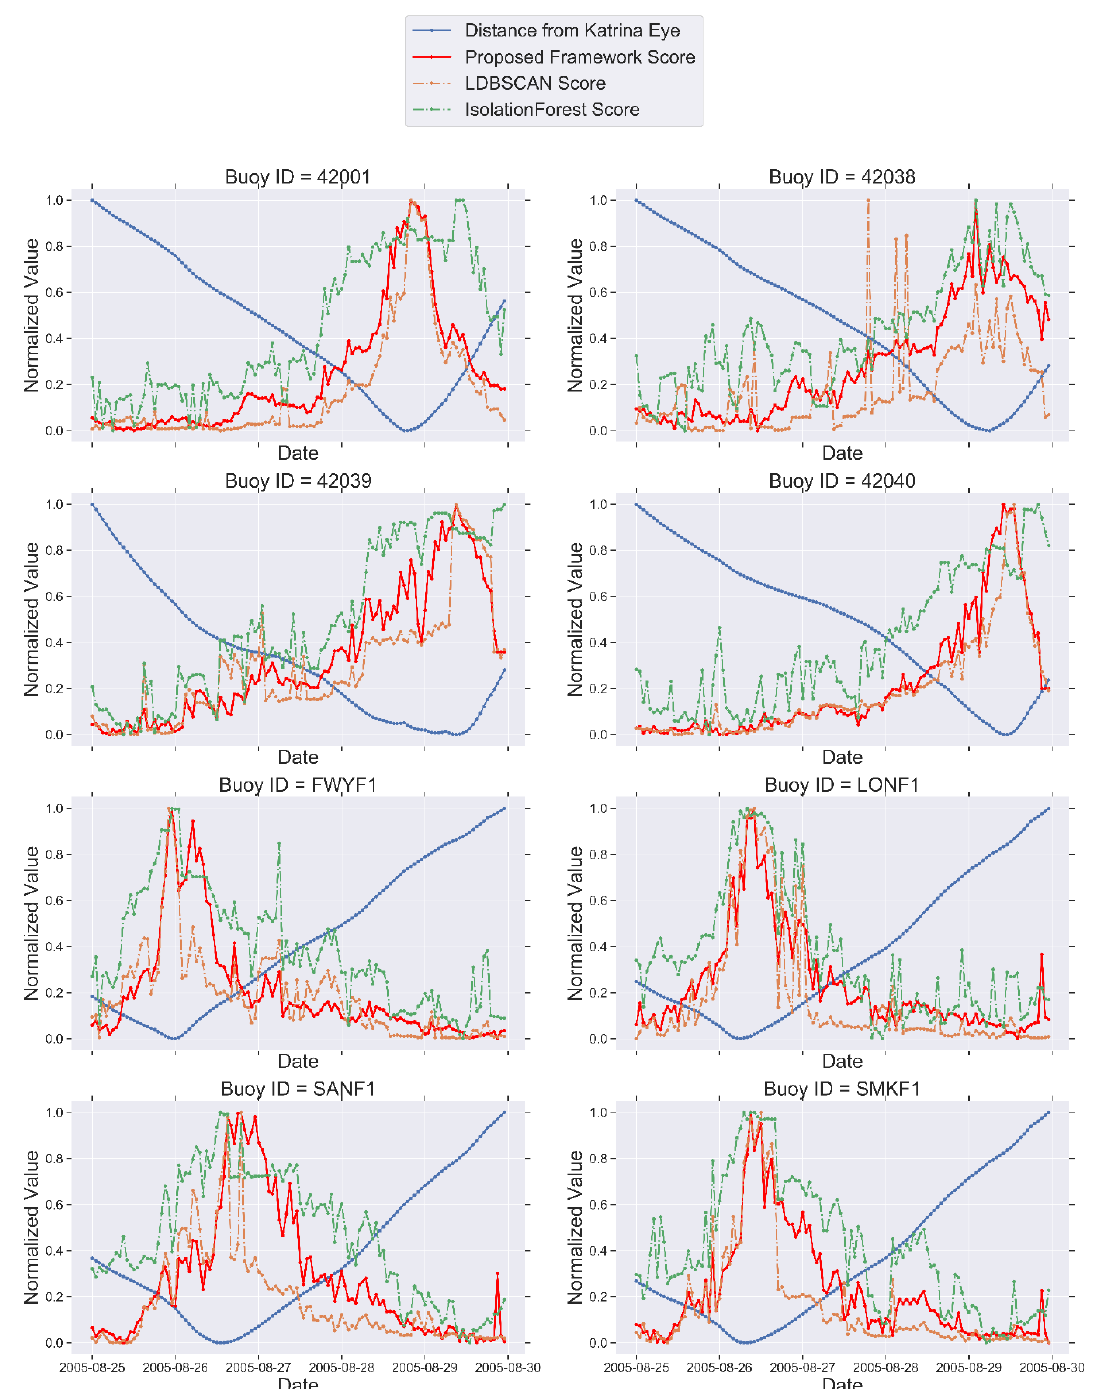
Figure 8. Anomaly score comparison of the proposed framework, IsolationForest and the LDBSCAN algorithm. Normalized anomaly scores are plotted against the normalized distance between buoys and the center of the Katrina.